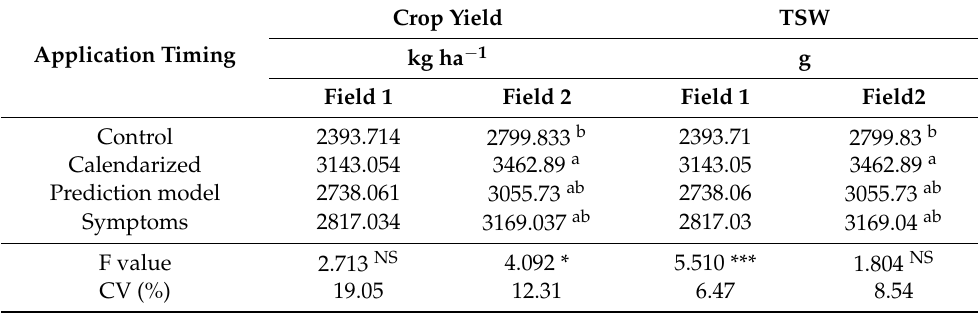
Table 5. Mean values of soybean crop yield (kg ha − 1 ) and thousand seeds weight (TSW) (g), ac- cording to soybean rust effect of different application timings and soybeans cultivars, for each field tria